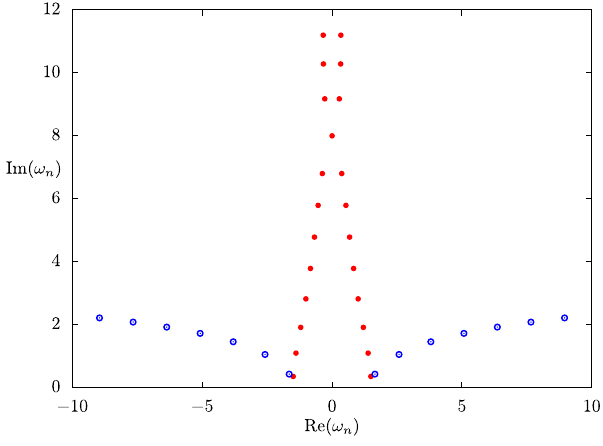
16. Infrared modification of the Schwarzschild Schwarzschild potential ( l ¼ 2 , either Regge-Wheeler or Zerilli) QNM, thus accounting for its instability as found in Ref. [44]. All → ∓ ∞ ; x QNM is recovered as x min max